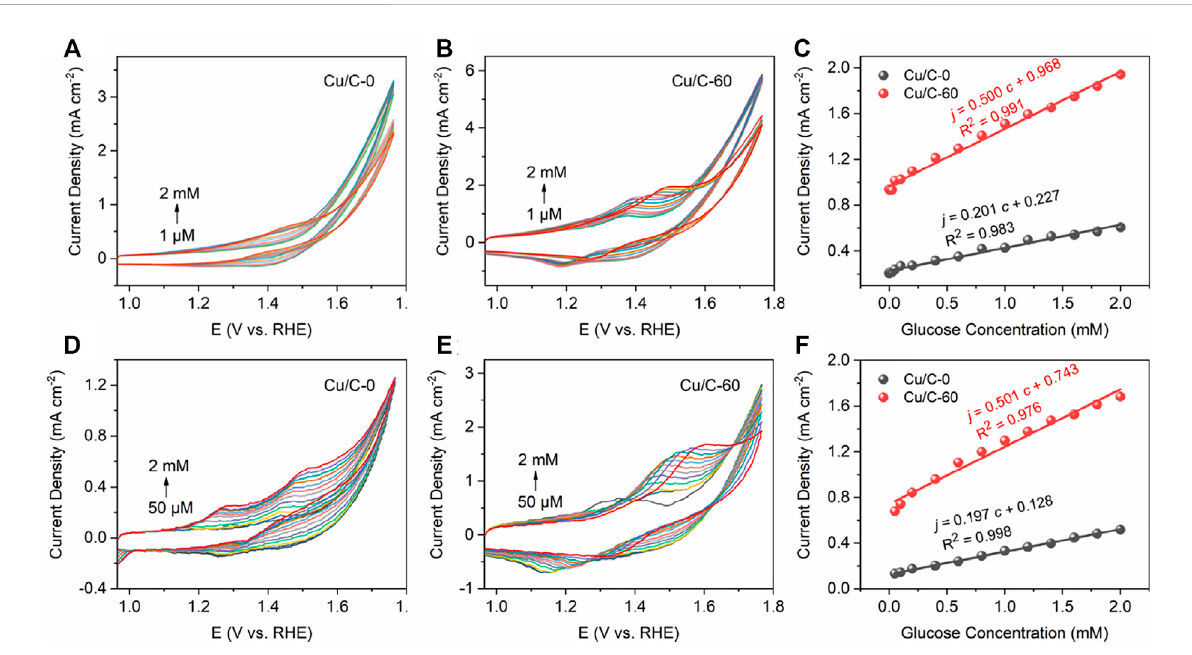
FIGURE 10 (A,B) CV curves recorded by connecting the three-electrode chip (Figure 9) to CHI760E electrochemical workstation which is the same as that used for measuring the data shown in Figures 1, 2. ( C ) Current densities as function of glucose concentrations. The current densities in (C) are the peakcurrentdensitiesoftheoxidationpeaksontheCVcurvesin (A,B) . (D,E) CVcurvesrecordedbyusingtheportableandcompactelectrochemical system (Figure 9). (F) Current densities as function of glucose concentrations. The current densities in (F) are the peak current densities of the oxidation peaks on the CV curves in (D,E) . The CV curves are recorded by adding various concentrations of glucose into the 0.1 M NaOH solution at the scan rate of 40 mV s − 1